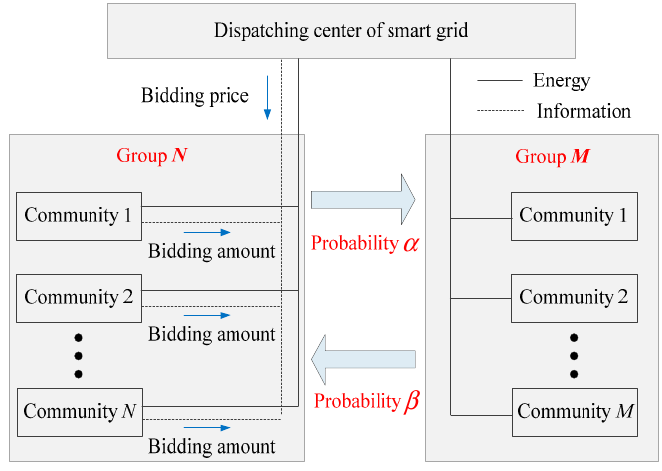
Figure 1. Framework for residential community participating in DR.